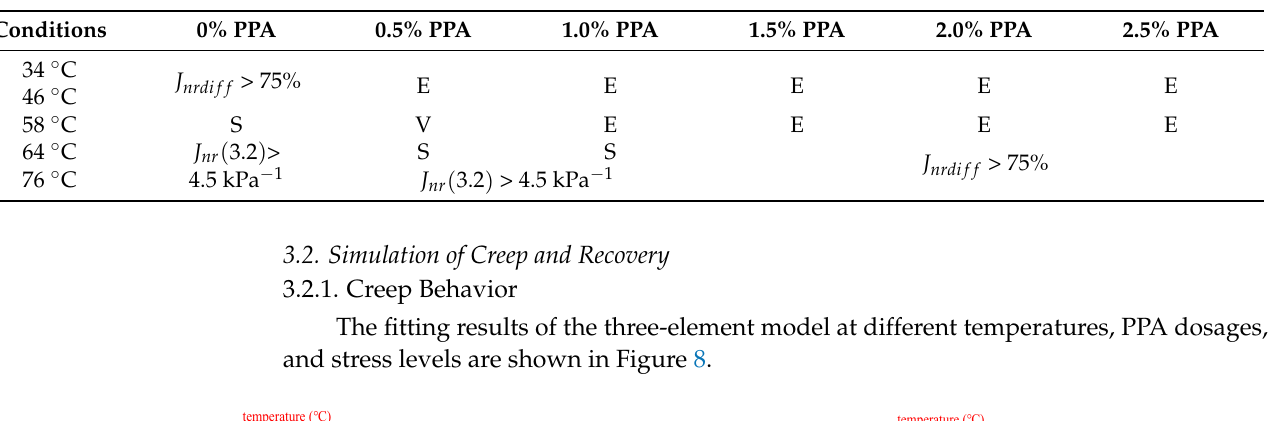
Figure 7. Appropriate tra ffi c levels for PPA − modi fi ed asphalt binders.